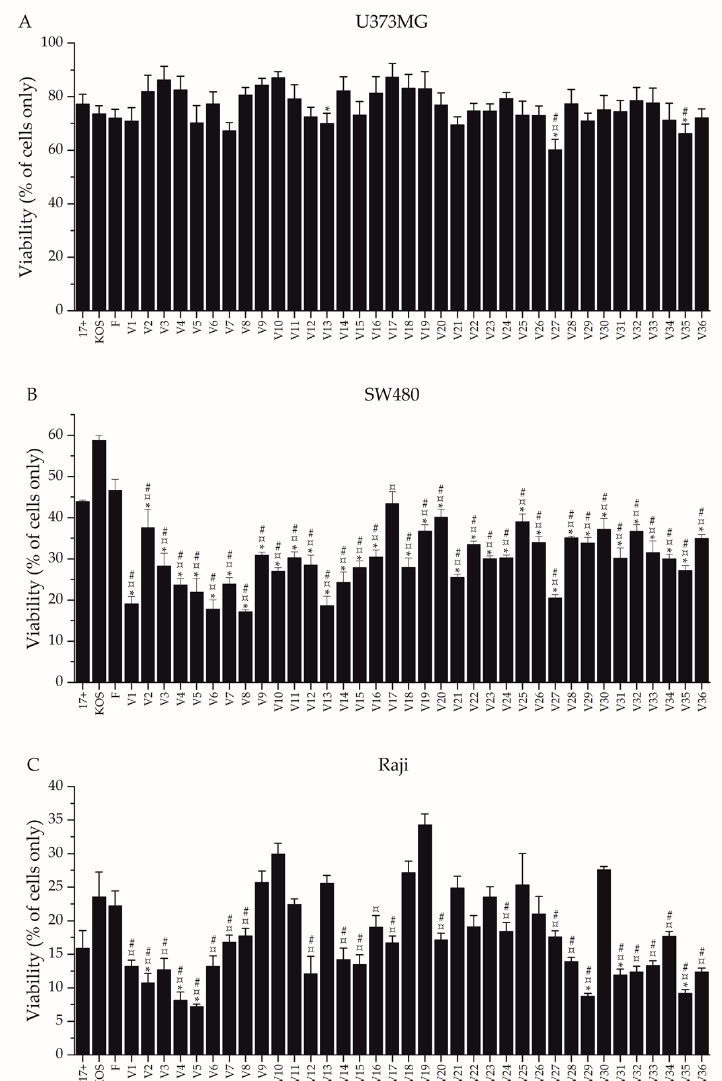
Figure 5. Cytotoxicity in selected cancer cell lines. The oncolytic effect of each clinical isolate and reference strain was determined in a cancerous cell line representing ( A ) neuroglioma (U373MG), ( B ) adenocarcinoma (SW480), and ( C ) lymphoma (Raji). The cells were infected with 2 pfu/cell of each strain and measured for viability at 4 days post infection, utilizing a luminescent assay. The viability was determined by comparing the signal derived from the infected cells to that derived from uninfected cells. The bars represent the percentile viability of the cells, while the whiskers represent the standard deviation of the mean ( N ≥ 4 per each condition). Statistical differences against each of the reference strains were determined by pairwise comparisons. Any statistical differences found in pairwise comparisons with the reference strains are presented: against 17+ with an asterisk (*, p < 0.05), against F with a number sign (#, p < 0.05), and against KOS with a currency sign (¤, p <